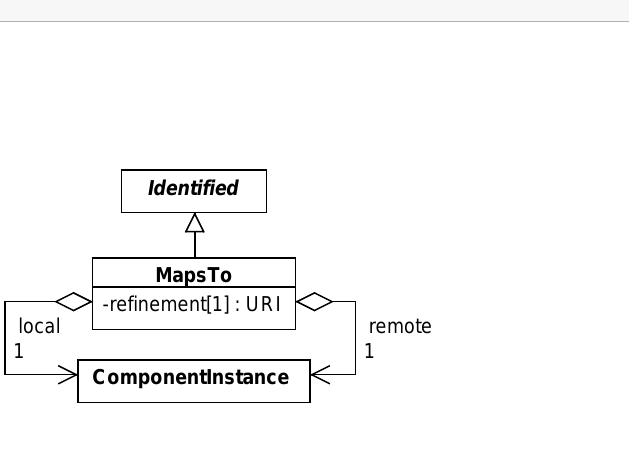
Figure 9: Diagram of the MapsTo class and its associated